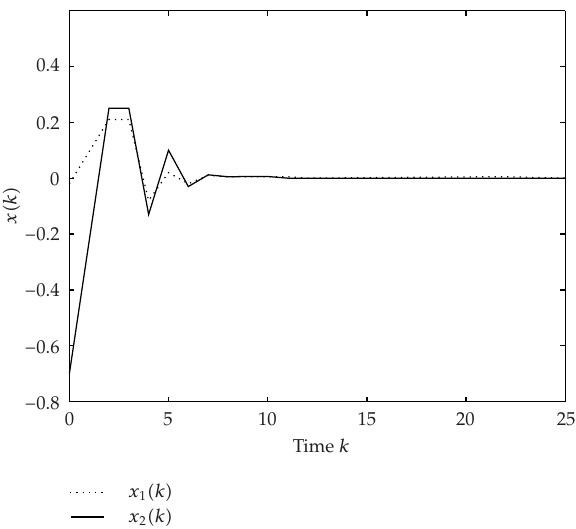
Figure 2: State response of the closed-loop